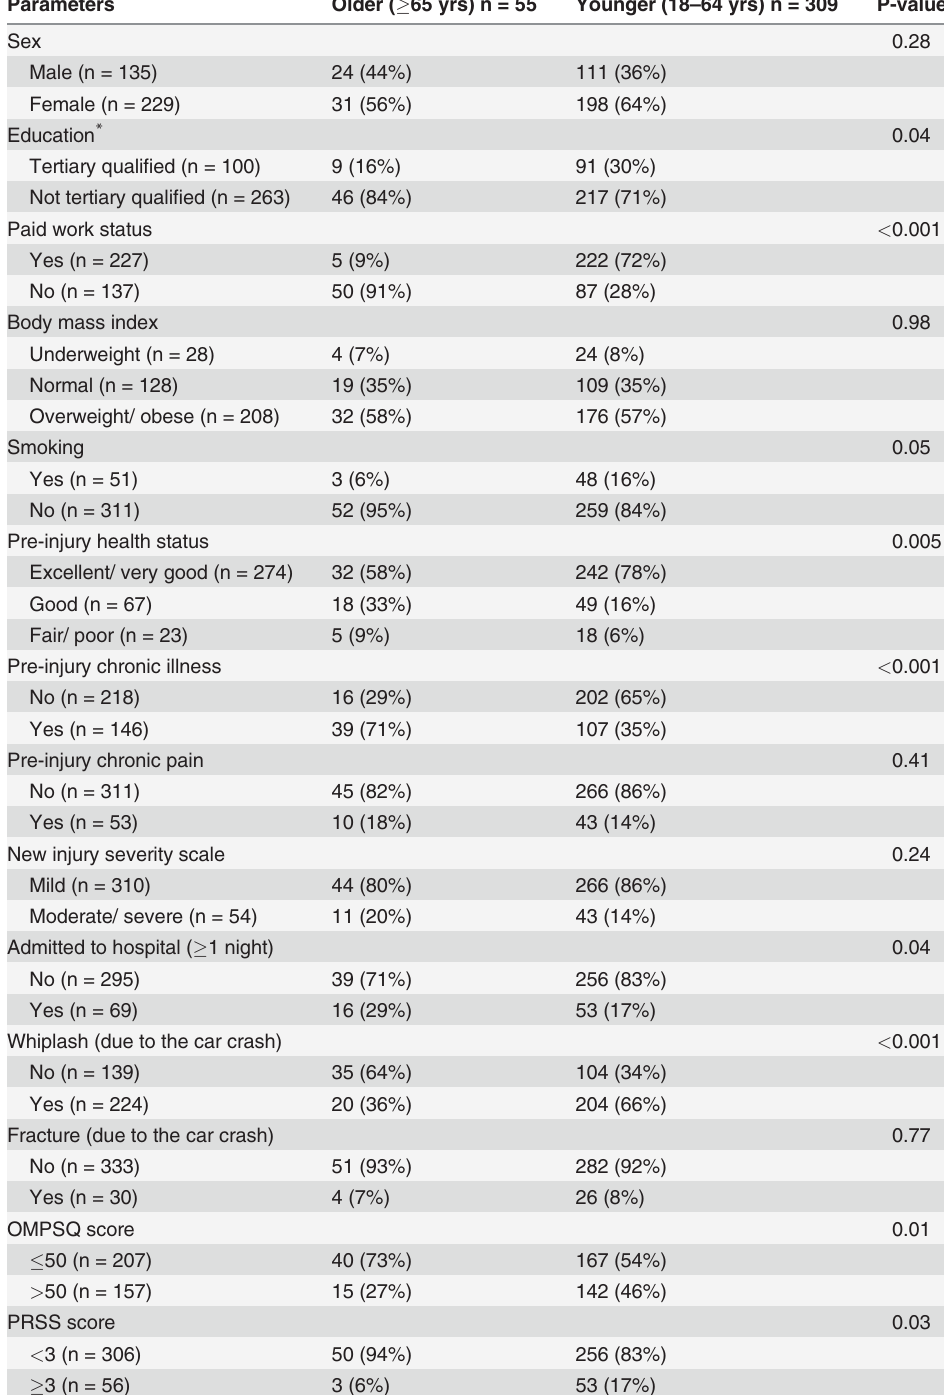
Table 1. Socio-demographic, psychological, health and injury-related characteristics of participants in the sub-acute phase, stratified by age-group (n = 64). Parameters